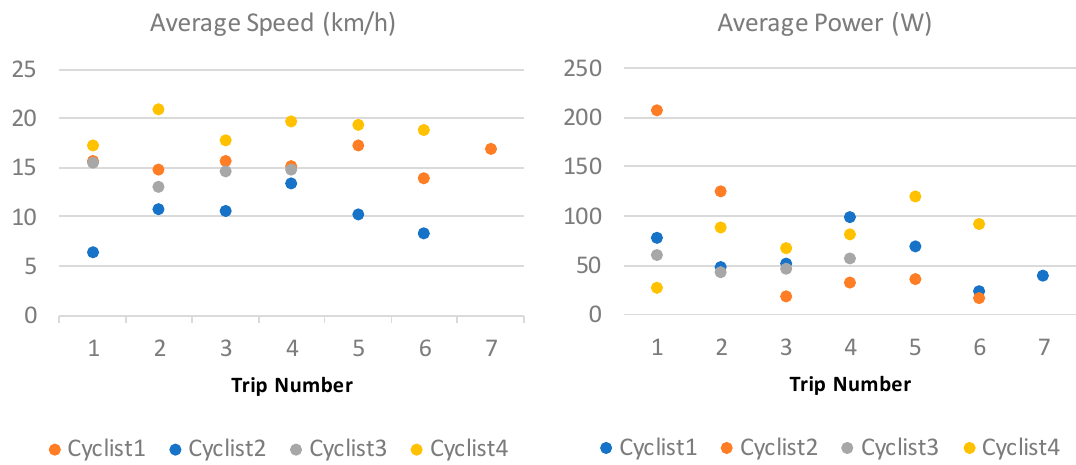
Figure 15. Acquired average velocity and power.